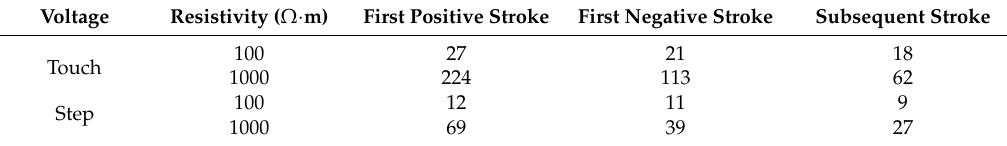
Table 3. Peak values (in kV) of the touch and step voltages calculated from Equation